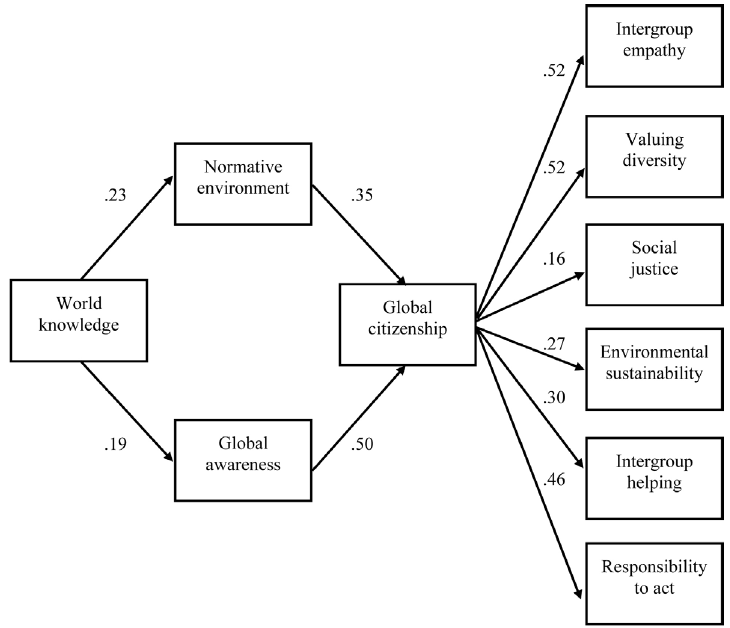
Figure 1: Influence of factual world knowledge on path model of antecedents and outcomes of global citizenship identification – all paths significant at p <